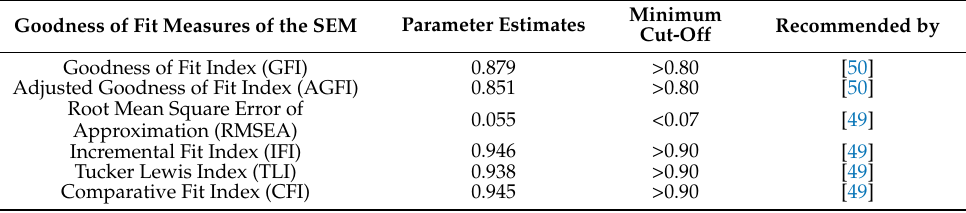
Table 5. The model